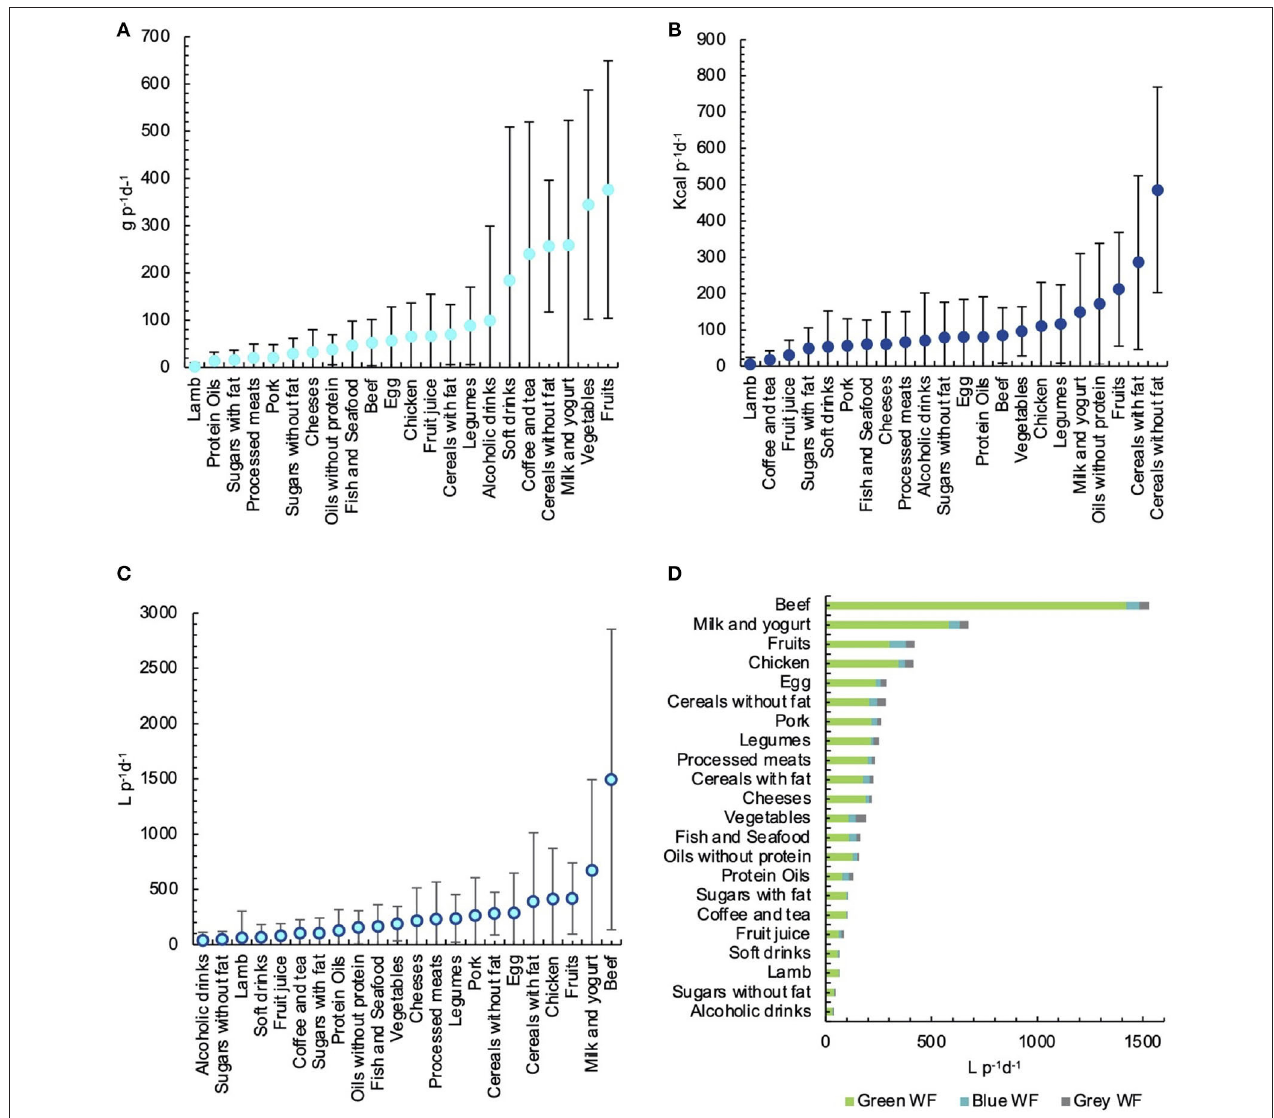
FIGURE 2 | Dietary and caloric intake and green, blue, grey, and total water footprint (WF) of the Mexican diet. (A) Grams consumed. (B) Calories consumed. (C) Total water footprint (WF) of the diet. (D) Green, blue, and grey water footprint